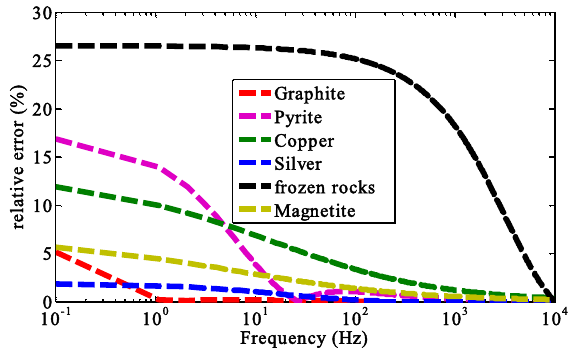
Figure 13. Relative error curves.